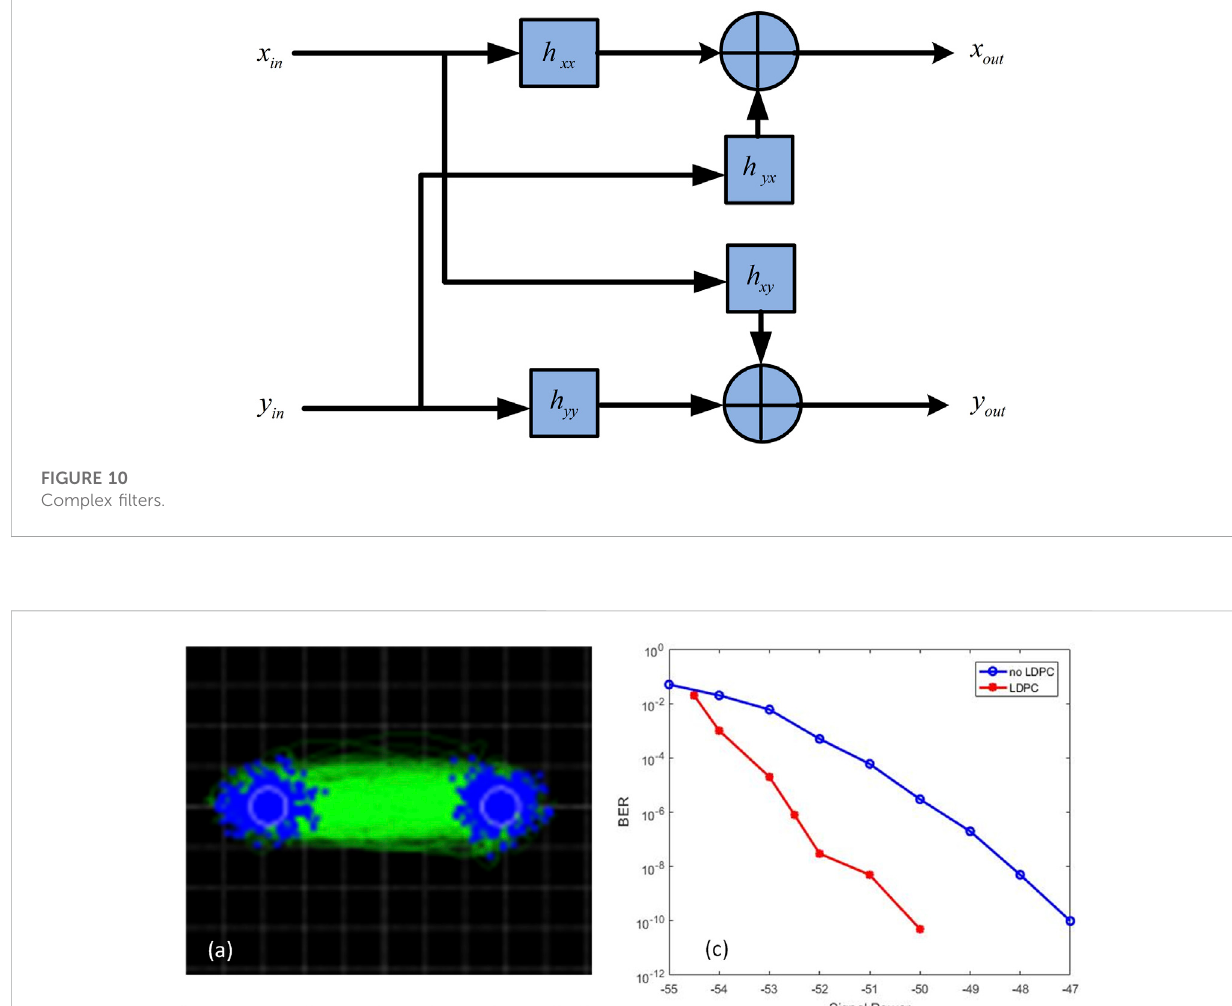
we test the receiver performance sequentially. A BPSK constellation diagram obtained via demodulation without encoding and a sensitivity of − 40 dBm is illustrated in Figure 11A. It can be seen that the noise introduced by the low-noise optical ampli fi er and the balance detector cause a large EVM value after demodulation (the data distribution is not concentrated in the white circle in the fi gure).